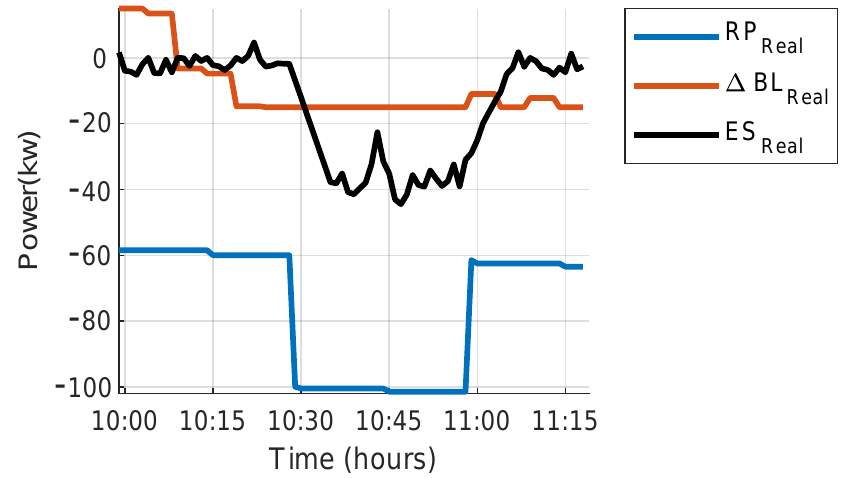
Figure 12. Scenario 1—battery and building load